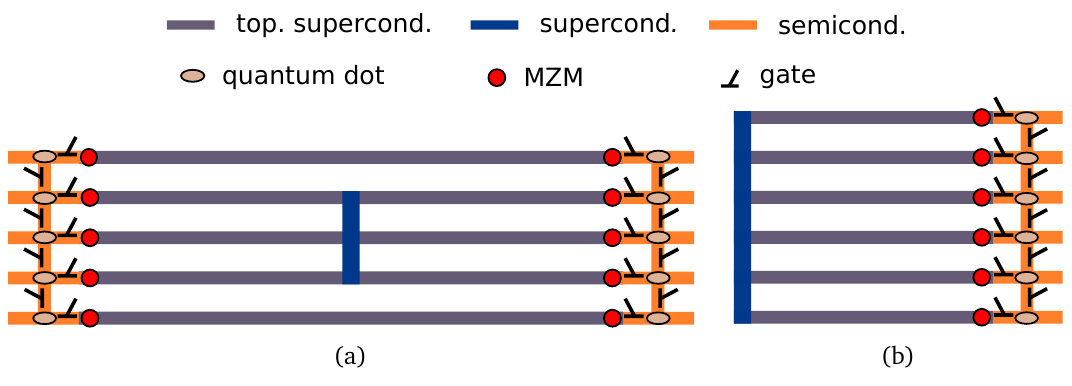
Figure 1: We consider two types of Majorana hexon architectures in detail: (a) the two-sided architecture and (b) the one-sided architecture. Shown here is a single qubit of each architecture with the required semiconducting quantum dots, cutter gates, and superconducting coherent links (top and bottom wire in the two-sided hexon) needed to perform all pairwise MZM measurements. The relative lengths of the vertical and horizontal dimensions are not to scale, and likely to be relatively much longer in the horizontal